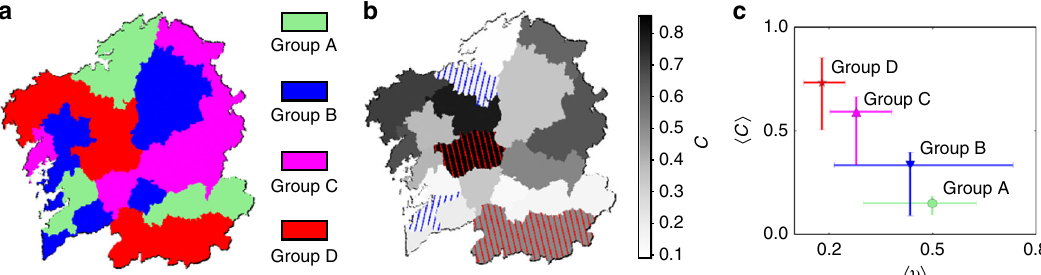
Fig. 1 Diversity of sociolinguistic dynamics in Galicia. a Galician regions colored according to the steady states that the dynamics of speakers should reach according to model Eqs. (1 and 4) and our data. b Parameter c i measured for each Galician region coded in grayscale (see color code at the right). Blue stripes tilted rightwards mark regions that are prominently urban, while red stripes tilted leftwards mark those regions which are prominently rural. c Parameter c i correlates inversely with the percentage of urban population as de fi ned in the main text. The average of both c i and u i has been taken for each group of regions (A to D). Error bars indicate the maximum and minimum values for